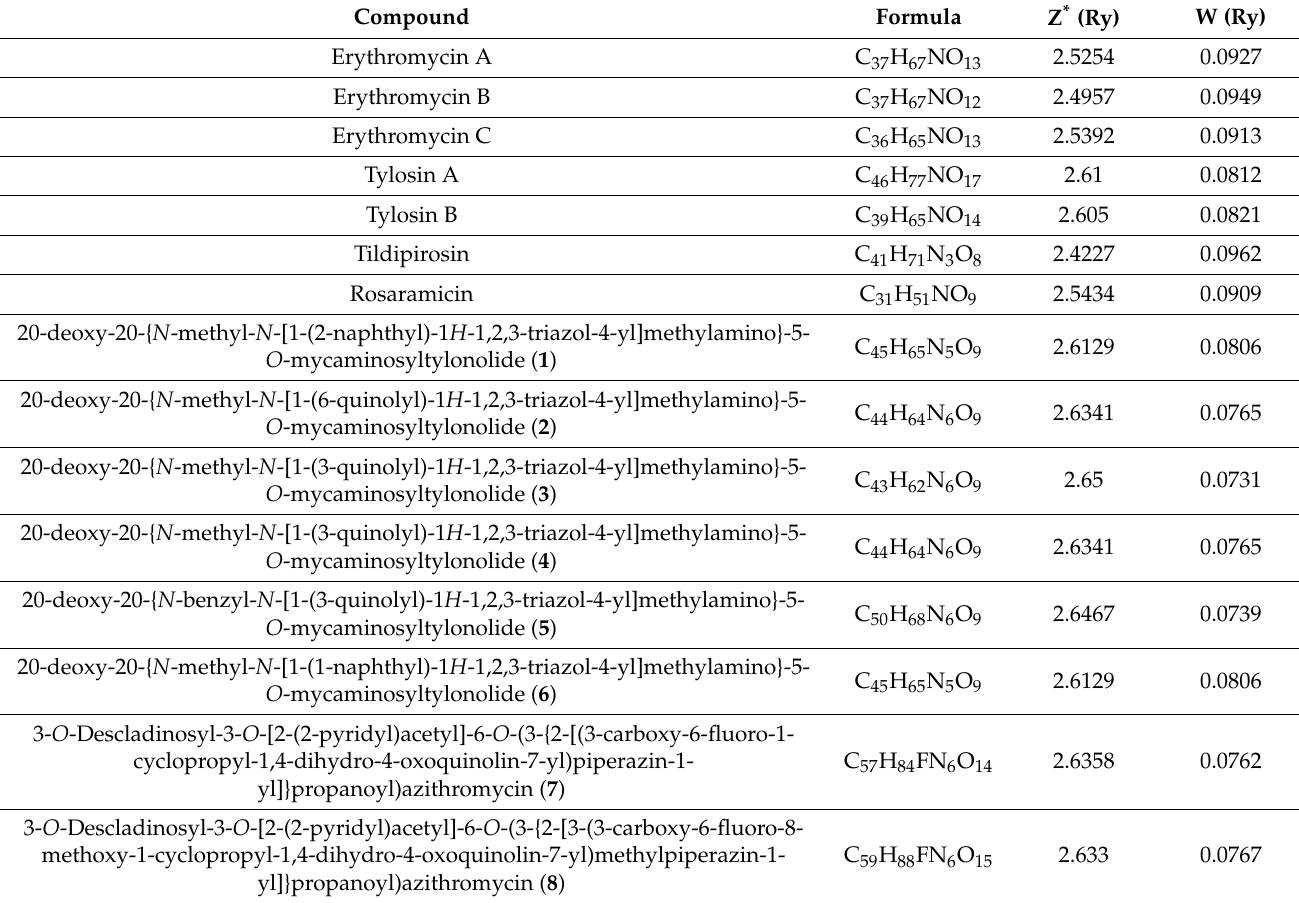
Table 2. Set of selected macrolides with calculated Z * and W values.